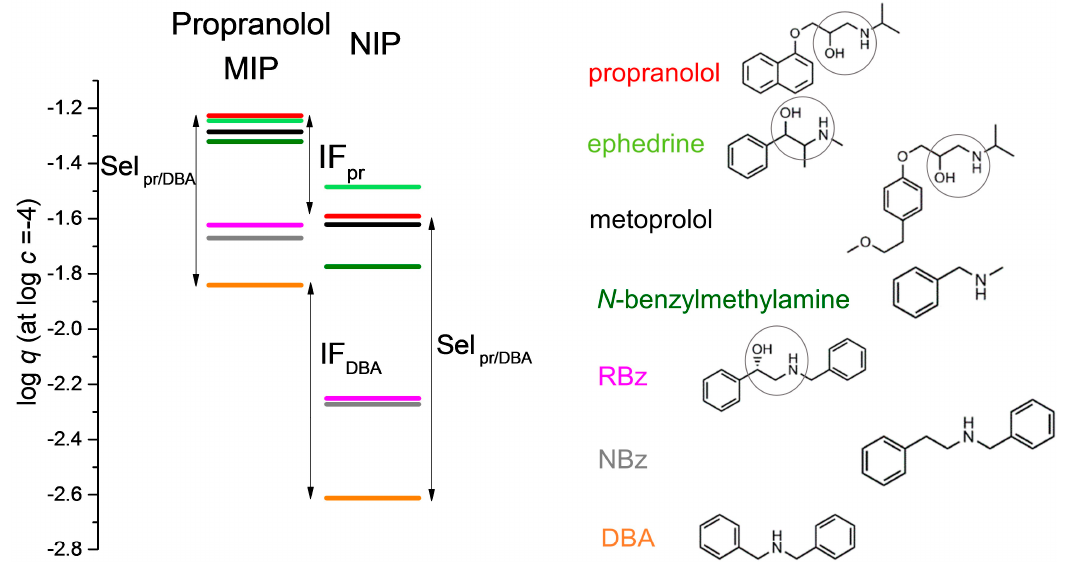
Figure 2. The selectivity ladder of seven amines on the propranolol MIP and its NIP, respectively, measured in the porogen acetonitrile. The structure of the compounds is shown on the right-hand side, with their names following the color coding of the plot.